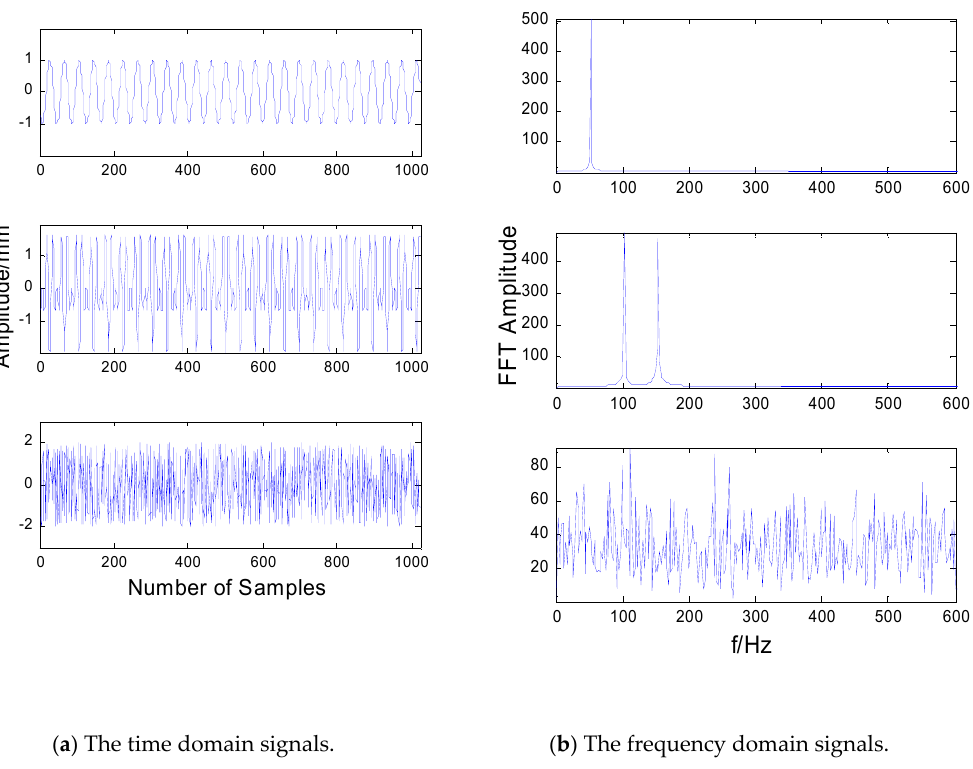
Figure 2. The time-frequency waveform of source signal. Figure 2. The time ‒ frequency waveform of source signal.